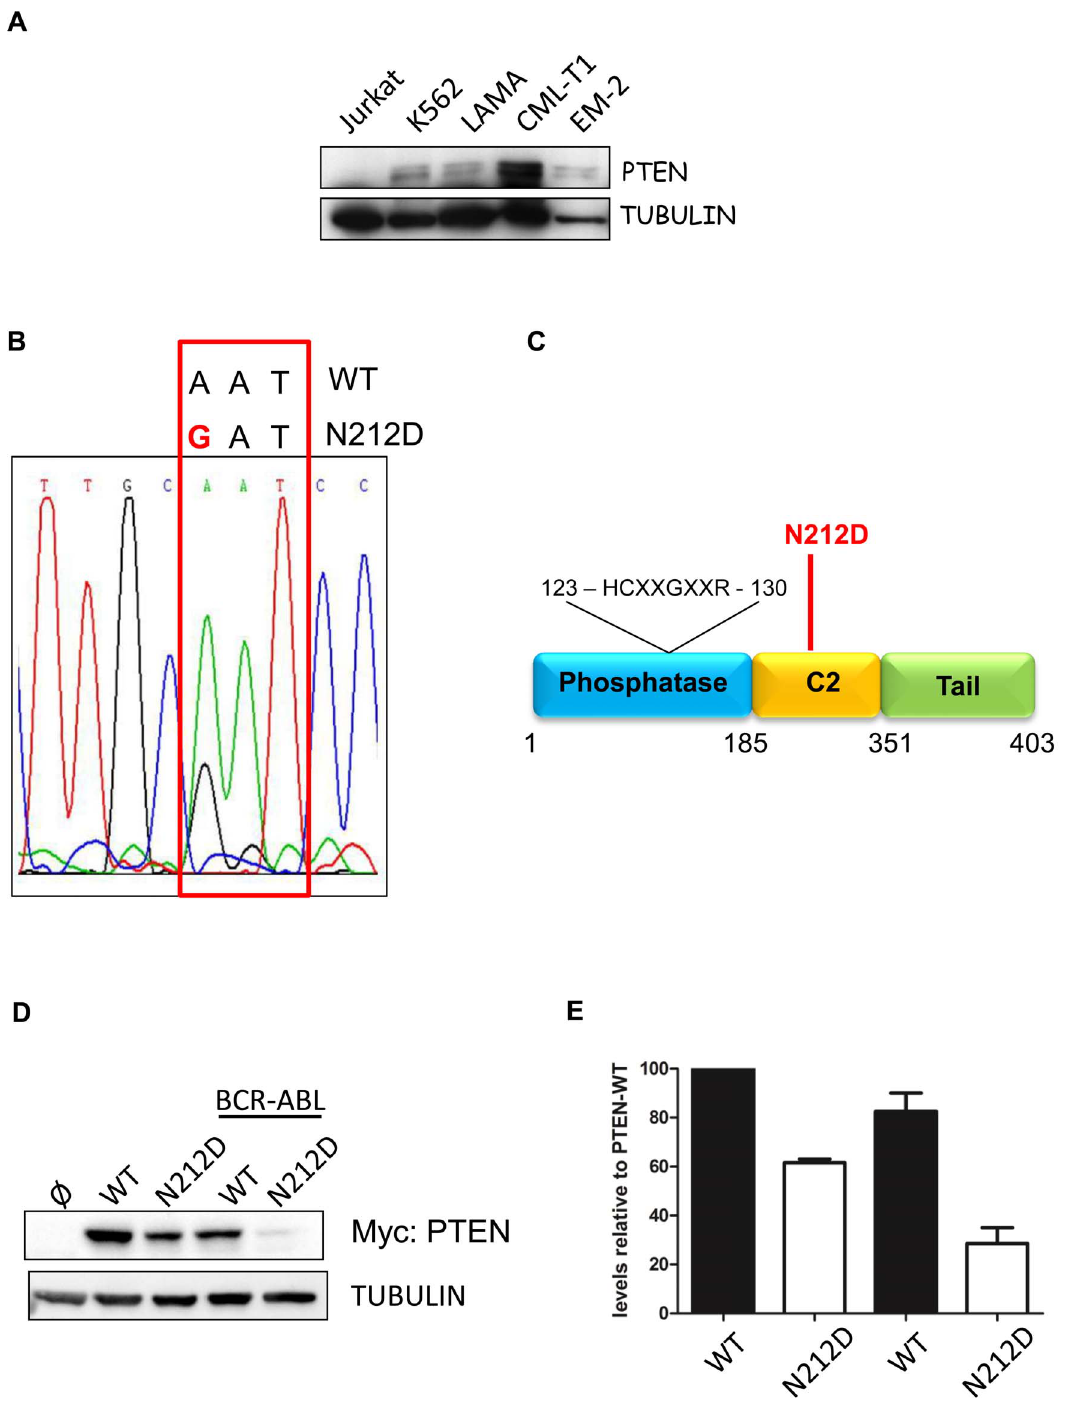
Figure 2. PTEN in CML blast crisis. A) PTEN protein levels in CML blast crisis. Jurkat cell line was used as a PTEN null cell line. B) Chromatogram from sanger sequencing analysis of PTEN in the EM2 cell line. C) Schematic representation of PTEN. D) Left: evaluation by western immunoblot of myc-tagged-PTEN-N212D point mutation expression after transfection of myc-tag-PTEN-WT and N212D plasmid in 292HEK cell line. Right: quantification of PTEN levels.